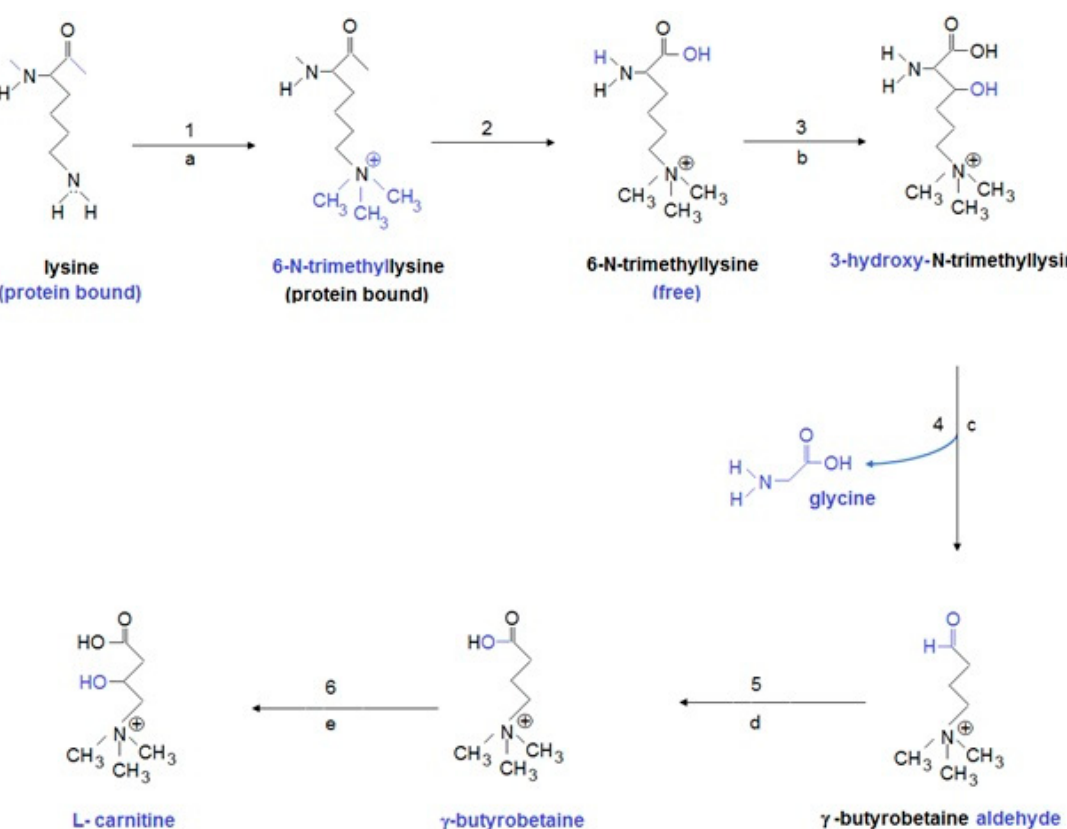
Figure 3. Carnitine biosynthetic pathway. Abbreviation: enzymes: 1, S-adenosyl methionine: ε -N-lysine methyltransferase; 2, protease (lysosomes); 3, ε -N-trimethyllysine dioxygenase (TMLD*) (mitochondria); 4, β -hydroxy- ε -N-trimethyllysine al- dolase (HTMLA) (cytosol); 5, 4-N-trimethylaminobutyraldehyde dehydrogenase (TMABA-DH) (cytosol); 6, γ -butyrobetaine dioxygenase (BBD*) (cytosol); second substrates and products: (a) S-adenosyl methionine (SAM) → S-adenosyl homocysteine (SAH); (b) 2-ketoglutarate + 02 → succinate + C02; (d) NAD+ → NADH + H+; (e) 2-ketoglutarate + 02 → succinate + C02; coenzymes: (b) vitamin C, iron; (c) pyridoxal phosphate; (e) vitamin C, iron. * genetically determined enzyme